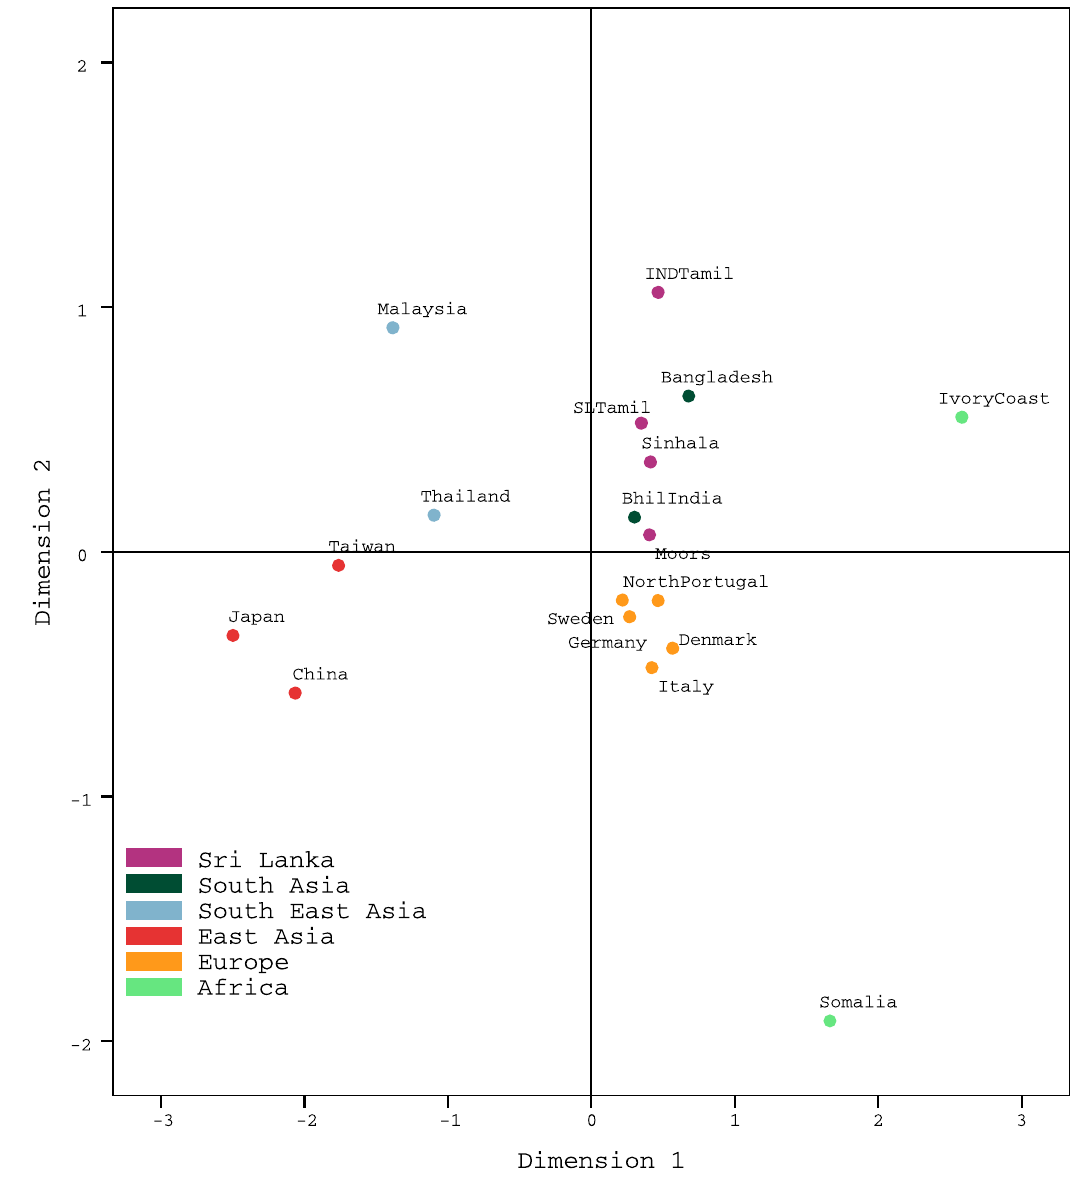
Figure 3. Two-dimensional MDS plot drawn from pairwise Fst values averaged over eight X-STR